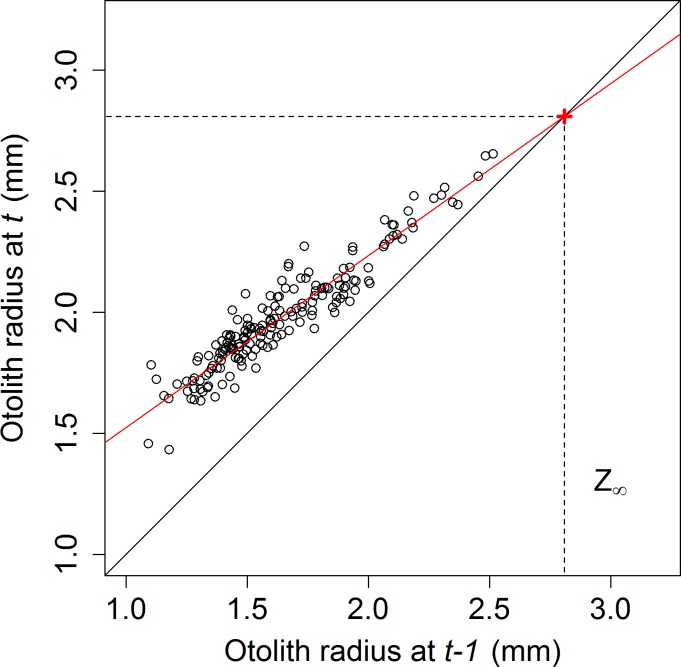
Linear growth of otolith in S. aurata, modelled as the otolith radius at a given year (Z’) against the otolith radius the previous year (Z).A linear regression model, Z′ = 0.7097 Z + 0.8154 + ε, (solid red line) was fitted to this data. The point at which the growth model and the 1:1 line (solid black line) intersect (red cross), represents the theoretical maximal otolith size attainable (dotted black line).